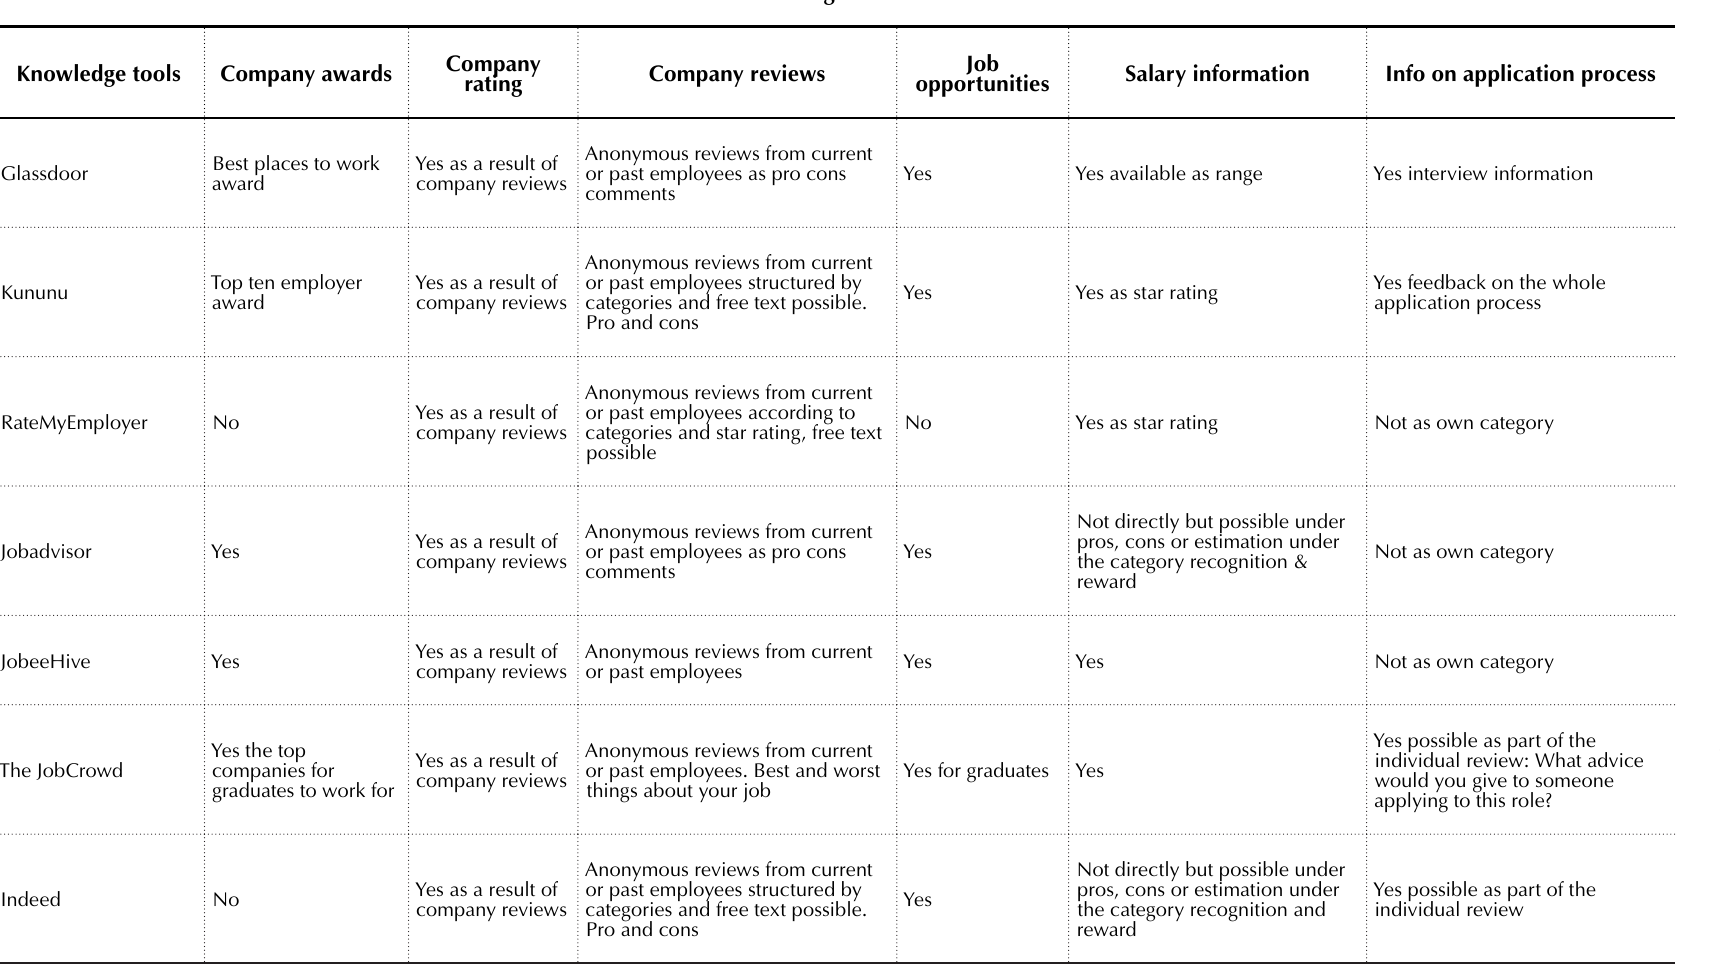
Knowledge to share